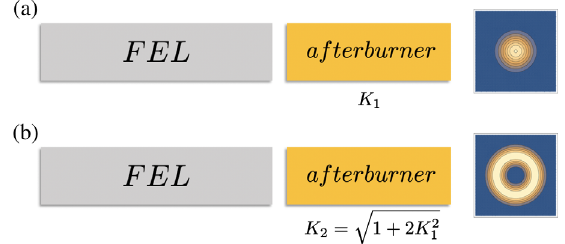
FIG. 7. OAM FEL afterburner scheme. In contrast to the typical case of coherent emission at the first harmonic (a), OAM light can be produced by tuning the helical undulator so that the incoming beam is bunched at the second harmonic (b). The upstream FEL uses reverse tapering to generate strong bunching with little radiation. Steering the electron beam prior to entry into the afterburner can transversely separate the OAM light from the FEL emission, as in Ref. [41].